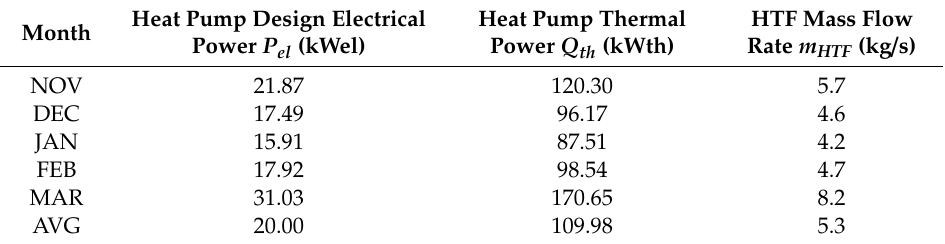
Table 1. Heat pump main performance.